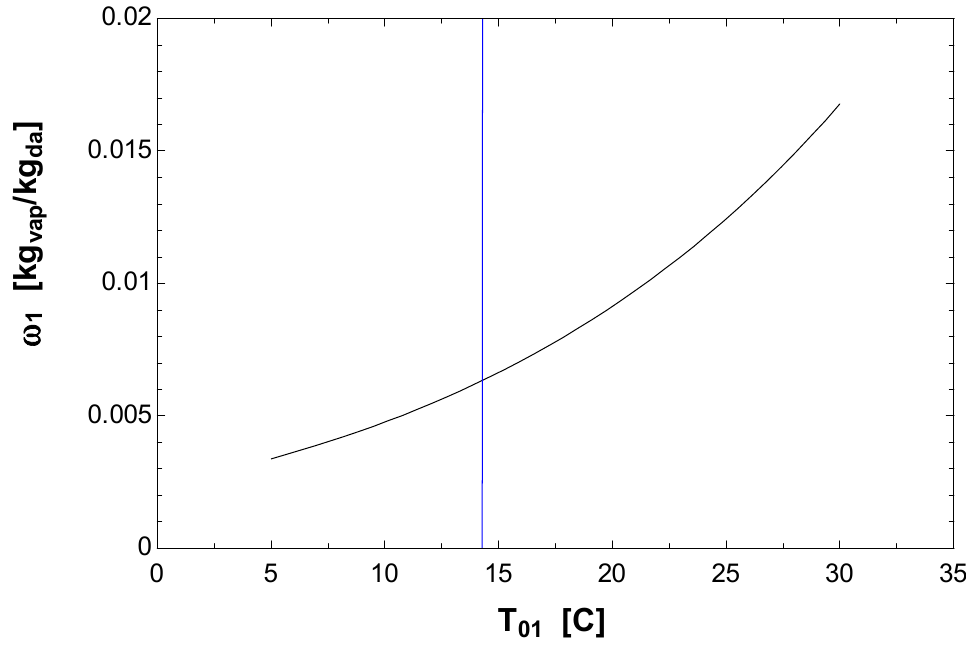
Figure 1. Specific humidity of air in the study area.